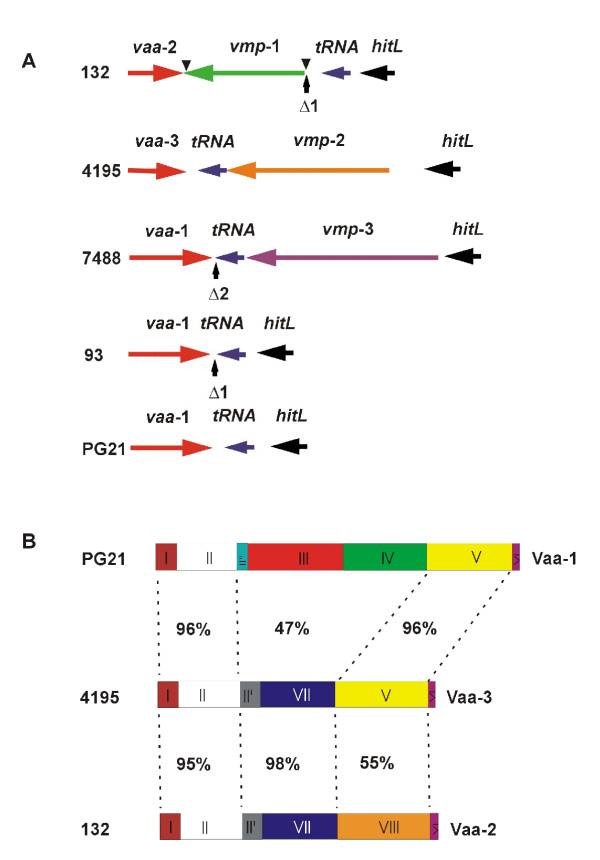
Variation of the vaa downstream region. A: Schematic drawing of the sequenced vaa-hitABL intergenic regions of the five isolates. Genetic fingerprints consisting of deletions (Δ1–2) and insertions (▼) of 90 bp upstream and 60 bp downstream to vmp-1 are shown. Identical vaa downstream regions were shared between isolates 4195 and PG21. The vaa gene categories are indicated by suffix -1, -3 or -2. B: Schematic comparison of the Vaa types of isolates PG21, 4195, and 132. The exchangeable cassettes are numbered III, IV, V, VII, and VIII, respectively. The percentages of identical residues between different parts of the proteins are shown.